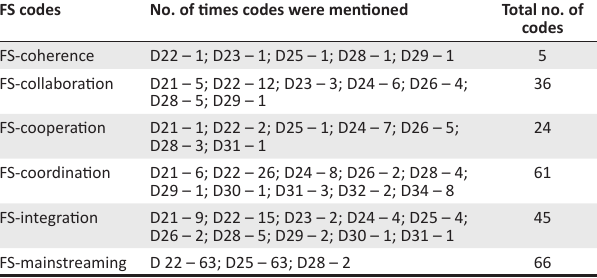
TABLE 8: Content in food security policies and legislation promoting